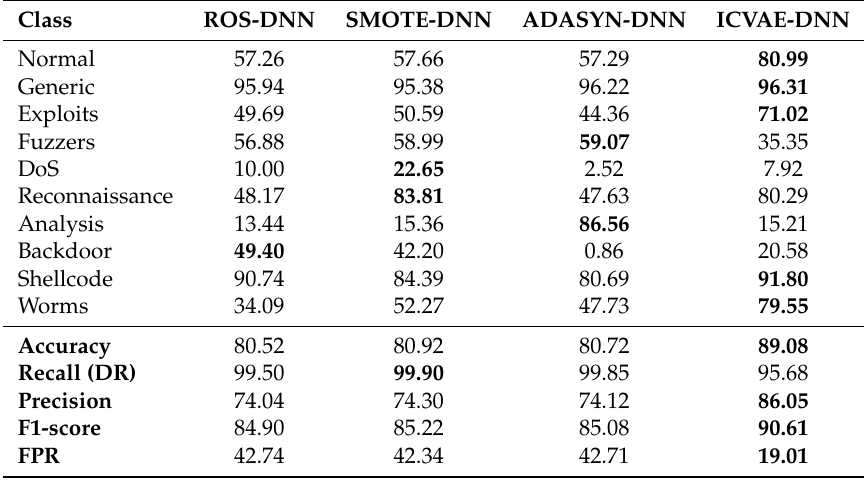
Table 8. Comparison of detection performance for different oversampling methods on the UNSW-NB15 dataset